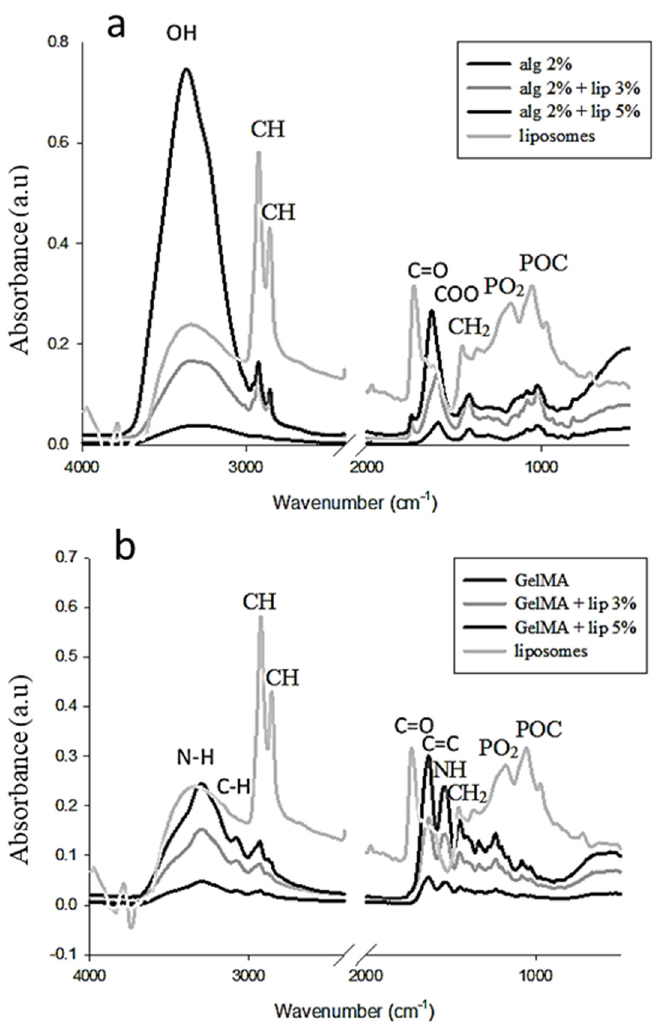
Figure 1. Surface analysis by FTIR of ( a ) alginate and ( b ) GelMA before and after functionalization with liposomes (3% and 5% ( w / v